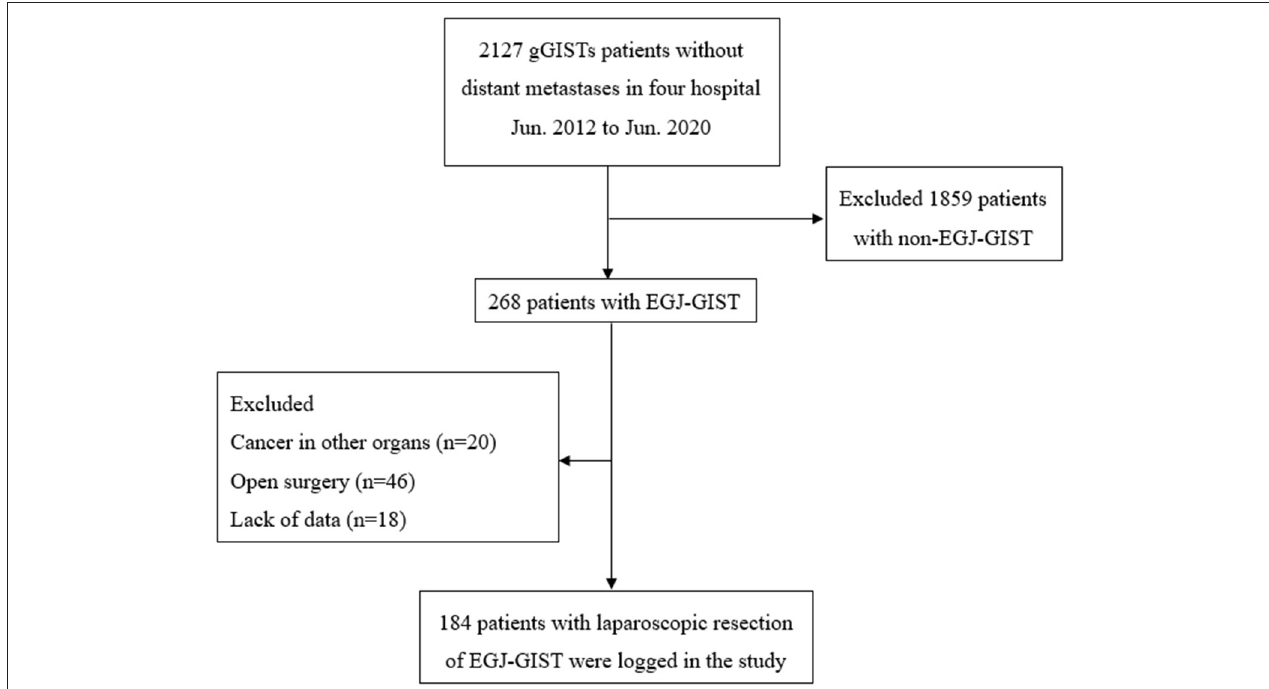
FIGURE 1 | Schematic diagram of patient cohort selection. gGISTs, Gastric gastrointestinal stromal tumors; EGJ-GISTs, Gastrointestinal stromal tumors in esophagogastric junction.